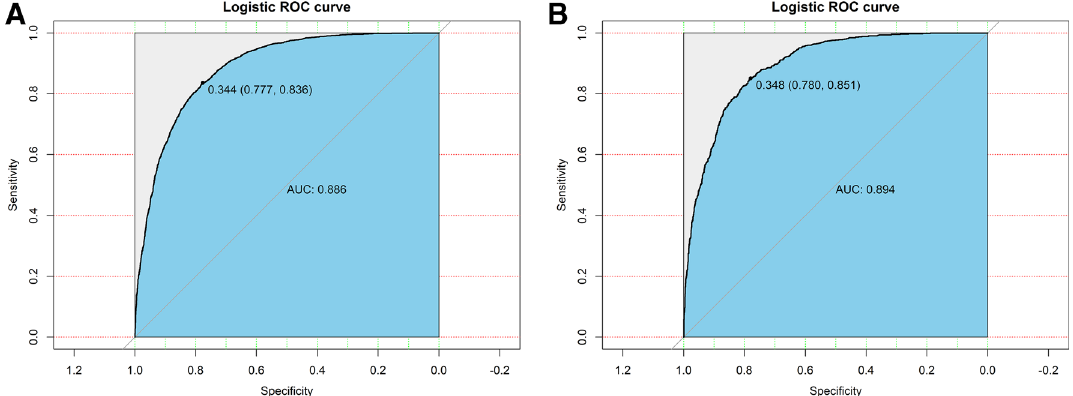
Figure 4. Receiver operating characteristic (ROC) curves validating the discrimination power of the nomogram in the development set ( A ) and the validation set ( B ).